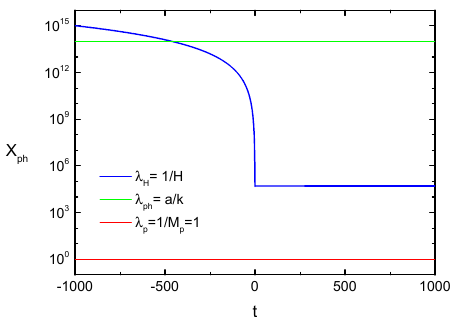
Figure 5. A sketch of the evolution of length scales in the emergent universe scenario. The vertical axis is the physical spatial coordinate X ph , and the horizontal axis is the cosmic time t . The physical wavelength λ ph = a/k of the mode with comoving wavenumber k is depicted in solid green line, while the Hubble radius λ H = | H | − 1 is depicted in the blue curve. We also draw the Planck length λ p = M − 1 in the red line for comparison. The wavenumber is taken to be k = 10 − 14 pl